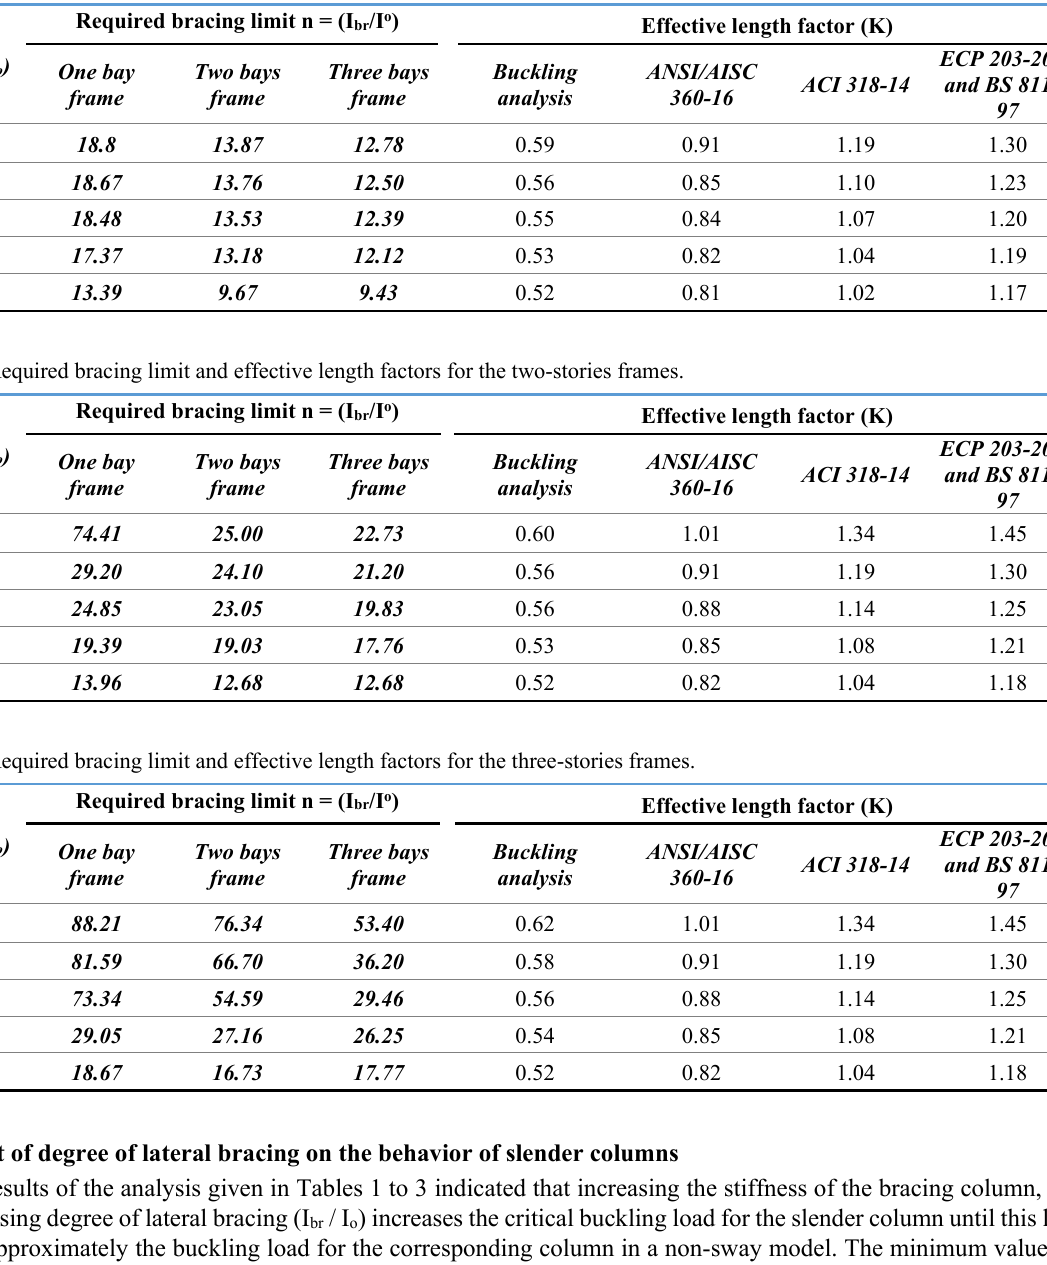
Table 1. Required bracing limit and effective length factors for the one-story frames.